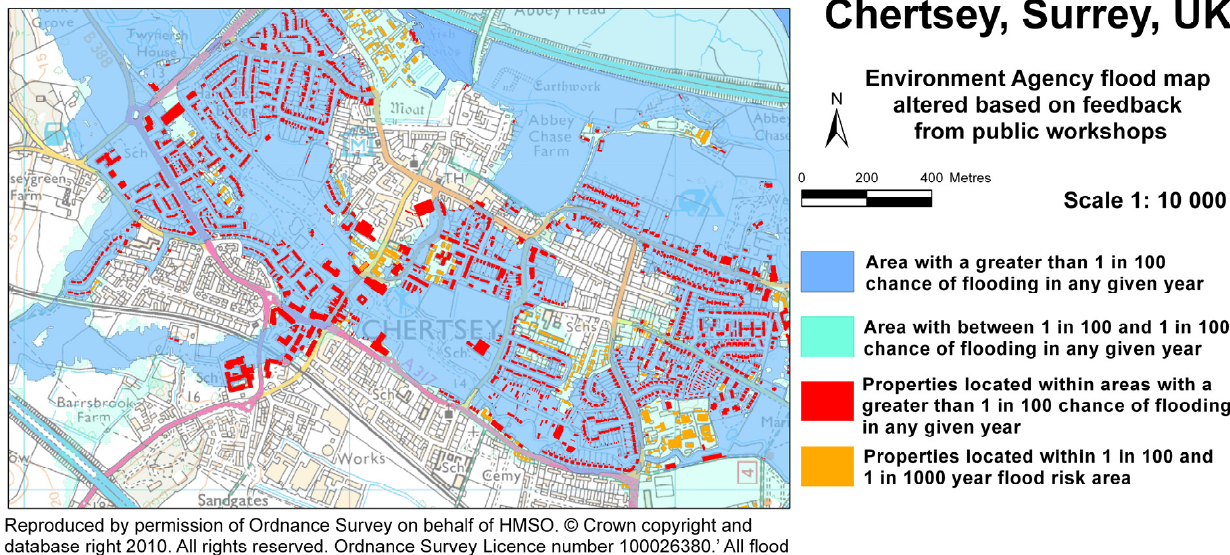
[Figure 3: Altered Environment Agency flood map for the public (case study England) contents have been refined based upon the preferences of Chertsey workshop participants. Map contents include flood extents for two different return periods and highlights buildings potentially affected. Emergency management information is not included in this example.]